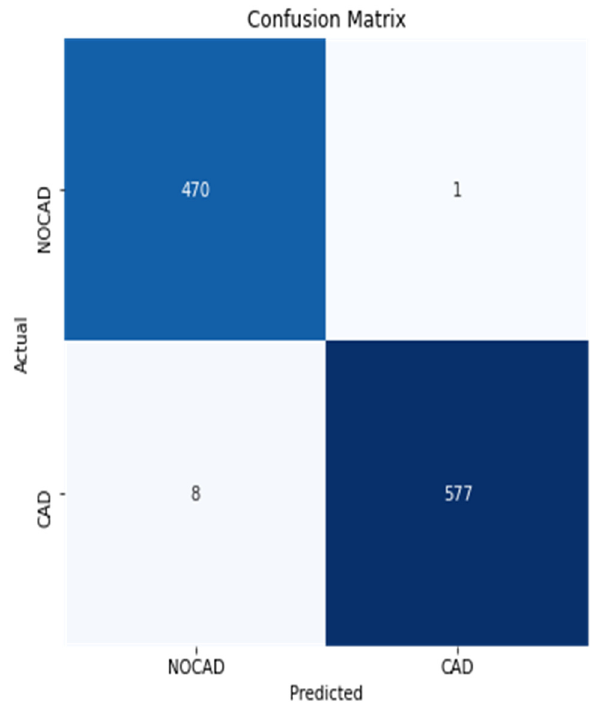
Figure 13. Confusion matrix for the single-lead ECG.